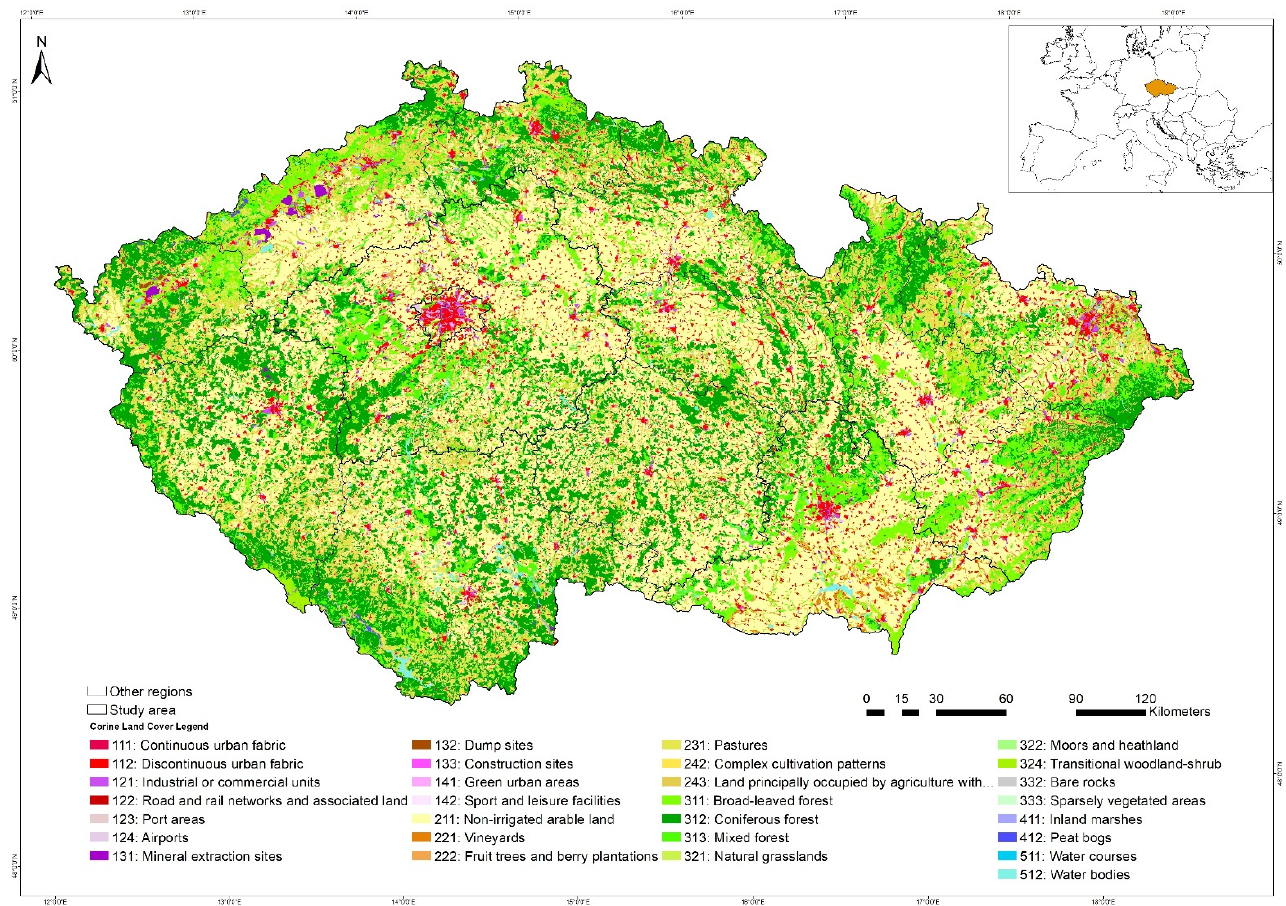
Figure 1. Location of the study area and the CLC categories in 2018. The Central Bohemian region is the largest region of Czechia and is in the central part of the historical region of Bohemia. It has an area of 10,928 km 2 and 1,385,141 inhab- itants [76]. The main sources of water pollution are industry, agriculture, and pollution from small municipalities, which lack sewer connections and wastewater treatment plants (WWTPs). In 2018, agricultural land occupied 60.2% of the territory of the region, for- est land 27.5%, and surface water 1.9%. Since 2000, the conversion of arable land into permanent pasture has been reported in built-up areas and courtyards [77].